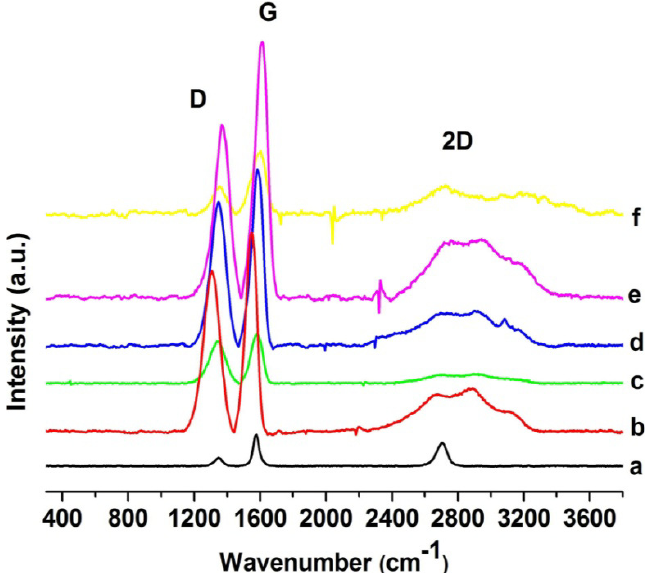
Figure 4. Raman spectra of: ( a ) graphite; ( b ) GO; ( c ) GEO; ( d – f ) chitosan-grafted graphene oxide at different temperatures: ( d ) CGEO1; ( e ) CGEO2; ( f )